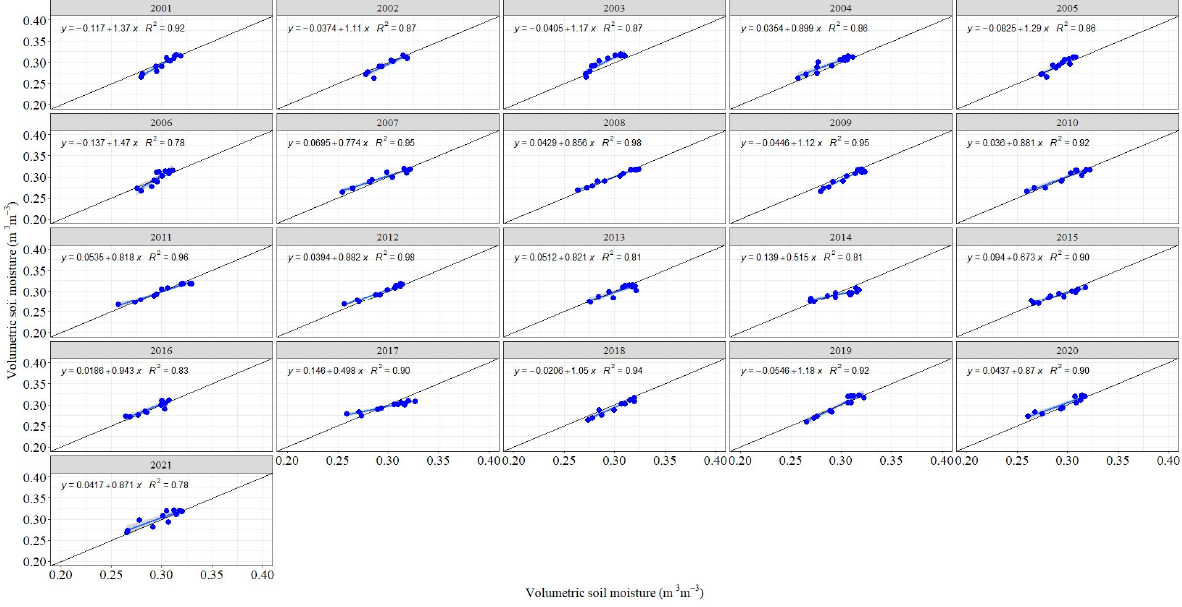
Figure 9. VSM regression analysis for observed and simulated data performed by ARIMA modeling (m 3 m − 3 ) for the years 2001–2021. Table 2. Statistical variables of the correlation of observed and simulated VSM data.